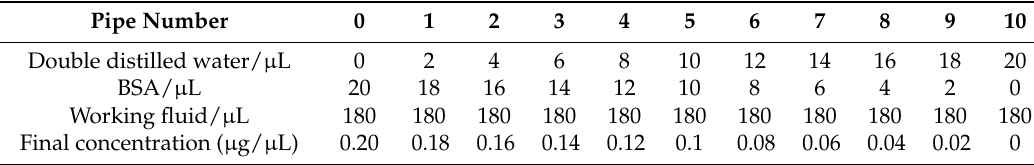
Table 1. Bradford quantitative standard curve production process.